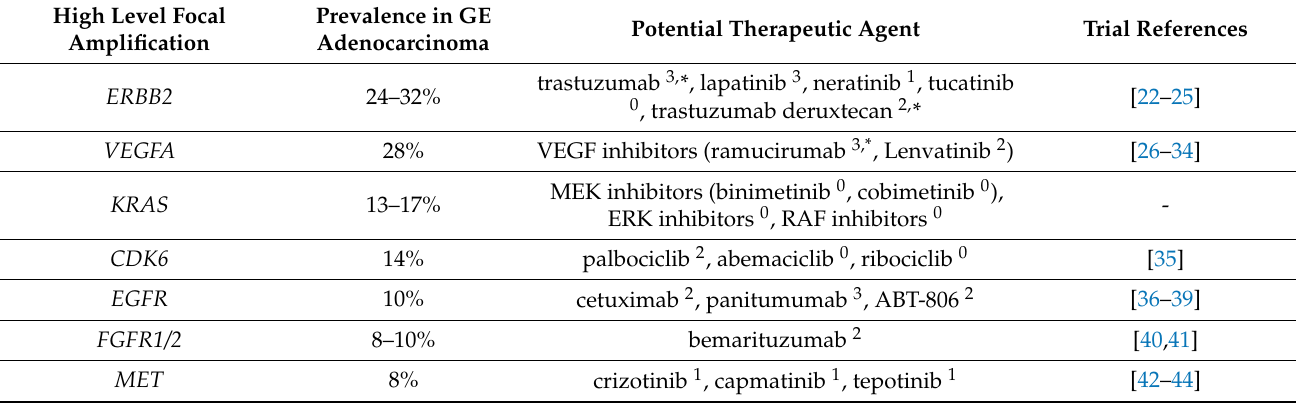
Table 1. Potential therapeutic vulnerabilities associated with chromosomal instability and high-level focal amplifications in gastroesophageal (GE) adenocarcinoma. Food and Drug Administration-approved drugs for gastroesophageal cancer are indicated by *. Aside from trastuzumab deruxtecan and bemarituzumab, most agents listed in this table have, thus far, not shown single-agent efficacy clinically, suggesting that combinatorial approaches may be needed